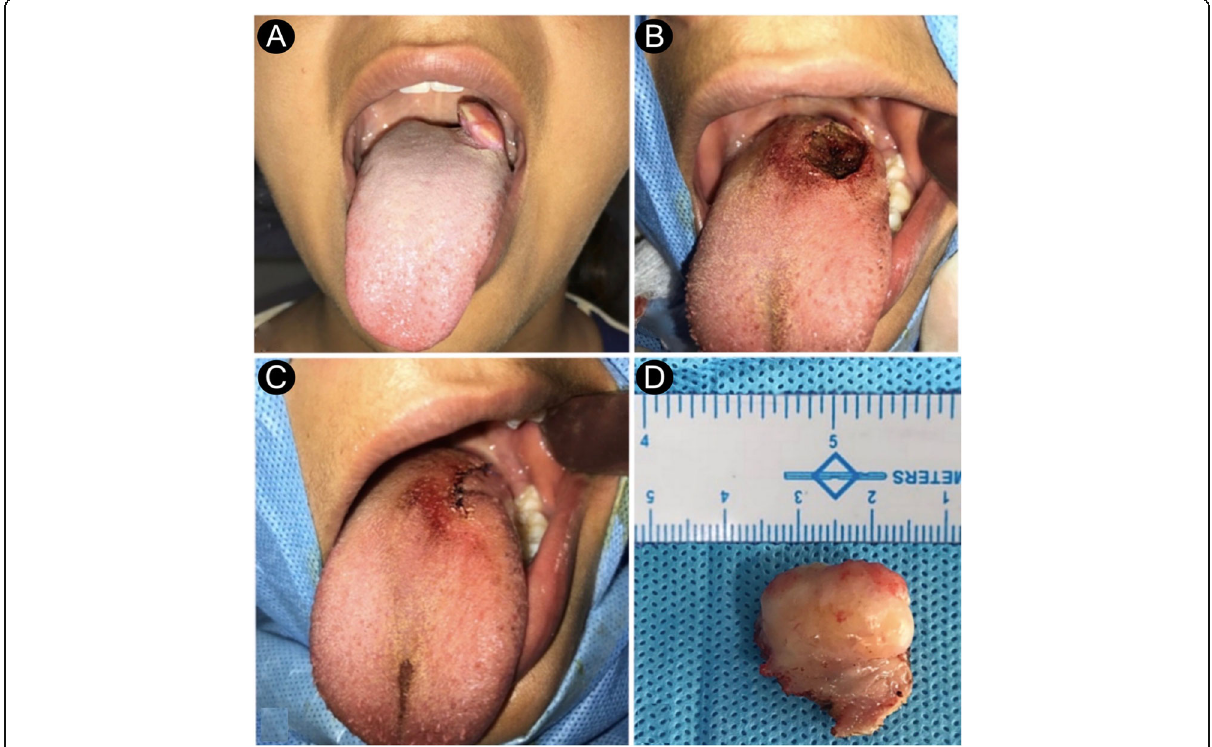
Fig. 1 a Showing the tumor involving the left posterior tongue with a wide base. b Intraoperative picture of the wound bed after complete excision. c Wound closed primarily, and d The specimen after complete excision with adequate